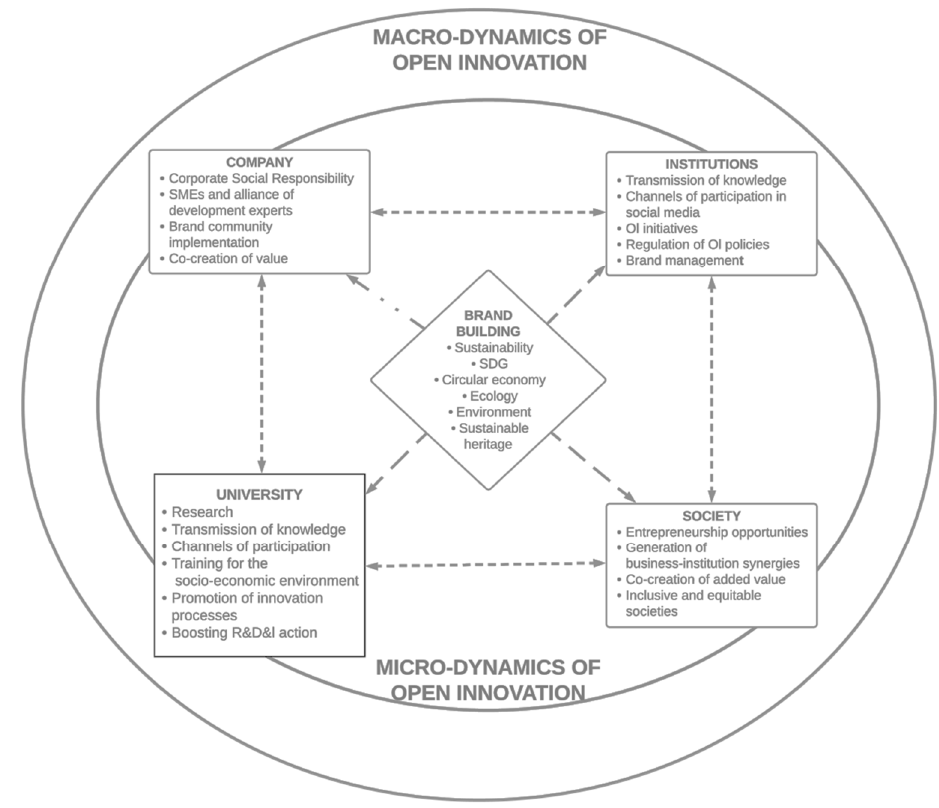
Figure 1. Quadruple helix model of open innovation. Carayannis and Campbell [75] and Yun and Liu [63]. Own elaboration.